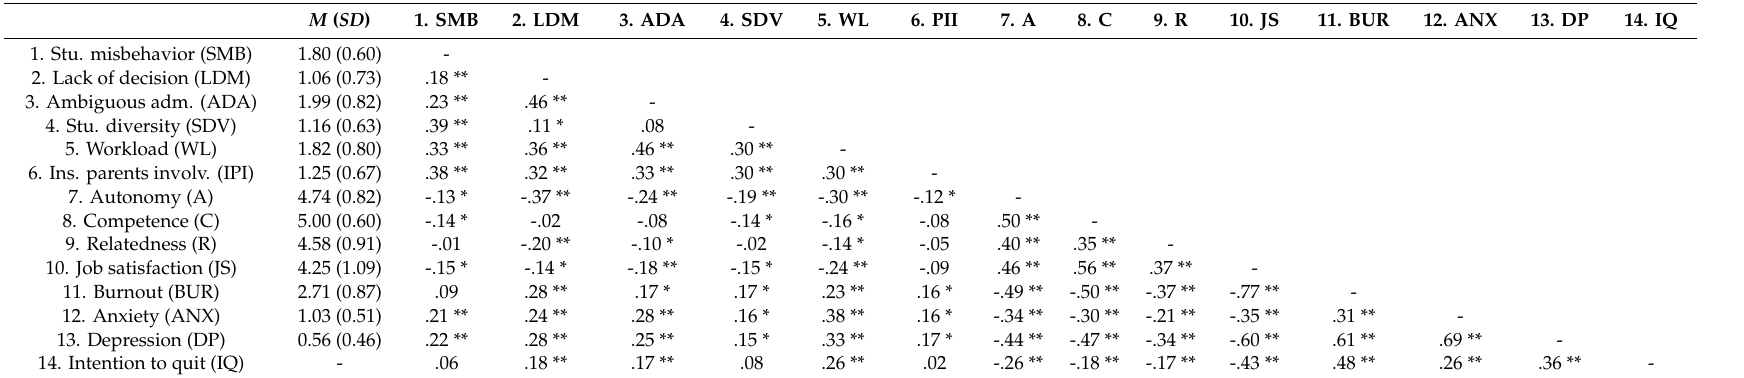
Table 5. Latent Correlations between Stressors, Basic Psychological Needs and Teachers’ Psychological